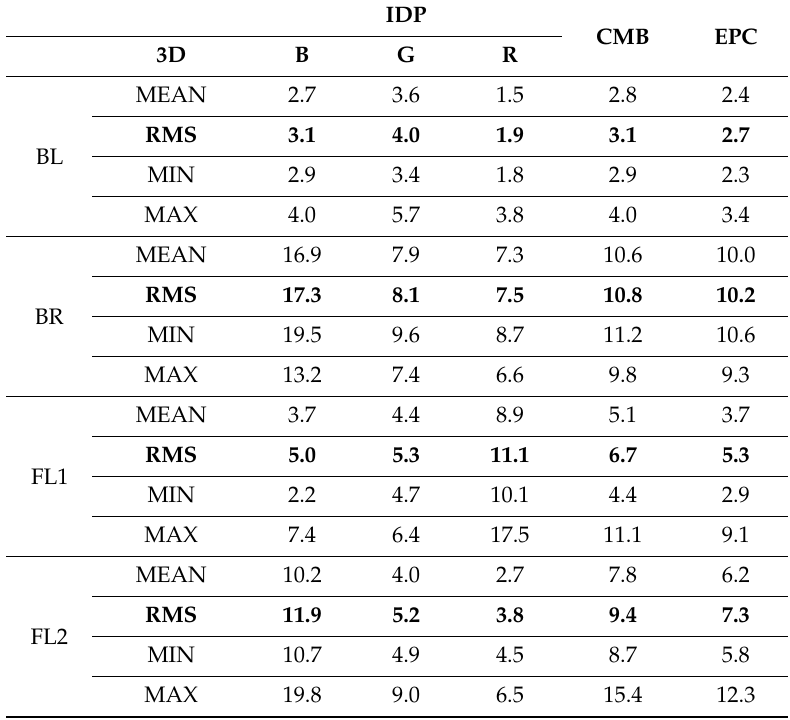
Table 11. The 7EOP accuracy assessment results. All results are shown in